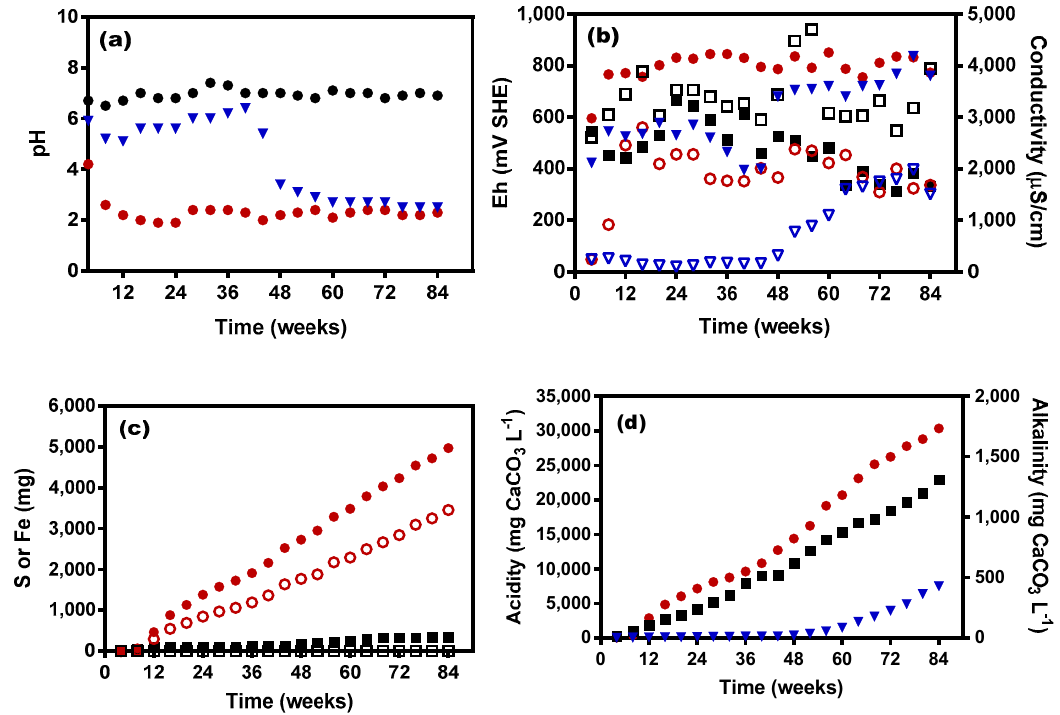
Figure 1. Leachate analyses: ( a ) Ph; ( b ) E h ; ( c ) cumulative S and Fe in effluents and ( d ) cumulative acidity and alkalinity. Legend: ( a ) —Control KLC, —CSW KLC, —BS + CSW KLC; ( b ) —Control KLC, —CSW KLC; —BS + CSW KLC. Secondary y axis (conductivity): —Control KLC, —CSW KLC, —BS + CSW KLC; ( c ) —Control KLC for S, —Control KLC for Fe, —BS + CSW KLC for S, —BS + CSW KLC for Fe; ( d ) —Control KLC, —CSW KLC. Secondary y axis (alkalinity): —BS + CSW KLC. Table 2. Pearson correlation coefficients ( r ) and associated statistical significance level for key parameter correlations in the Control KLC. Parameter pH E h Conductivity